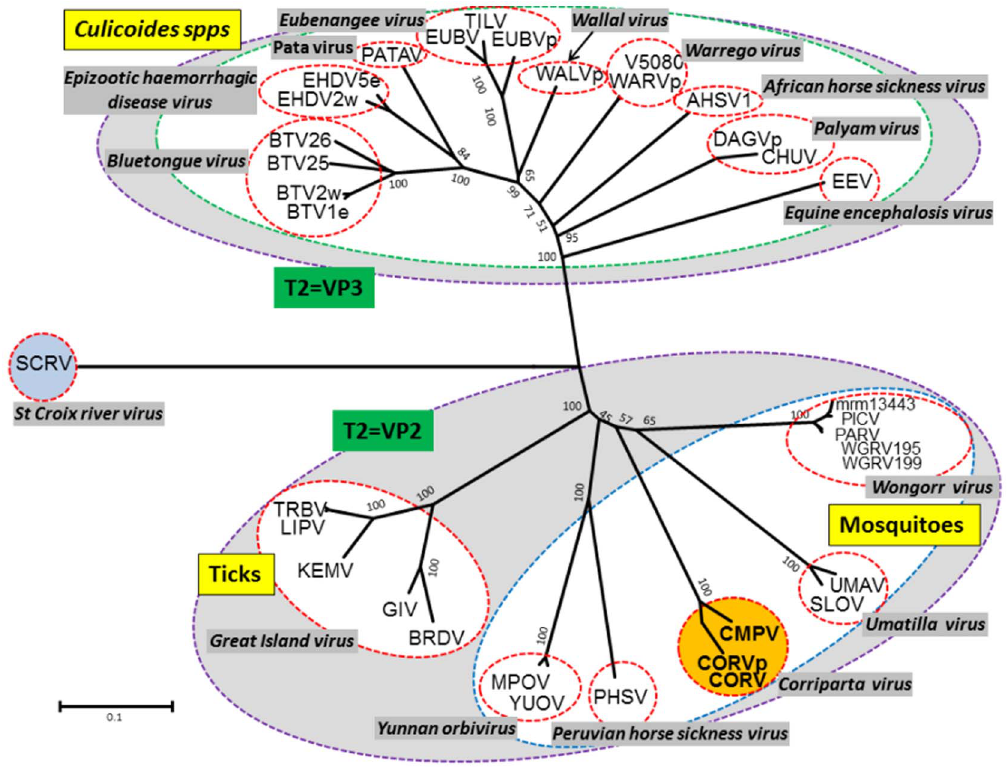
Figure 2. Unrooted neighbour-joining tree for orbivirus subcore-shell T2 proteins. A phylogenetic tree was constructed using distance matrices, generated using the p-distance determination algorithm and pairwise deletion parameters in MEGA 5 (1000 bootstrap replicates) [65]. Since many of the available sequences are incomplete, the analysis is based on partial sequences (aa 393 to 548, numbered with reference to the aa sequence of BTV-VP3(T2)). The numbers at nodes indicate bootstrap confidence values after 1000 replications. The tree shown in Figures 3 and 4 were drawn using the same parameters. The CORV and CMPV isolates are shown in red font in the amber coloured circle. Full names of virus isolates and accession numbers of T2 protein sequences used for comparative analysis are listed in Table S1 (supplementary data). ‘e’ and ‘w’ after serotype number indicate eastern and western topotype strains, respectively. T2 protein sequences (listed in Table S1 supplementary data)